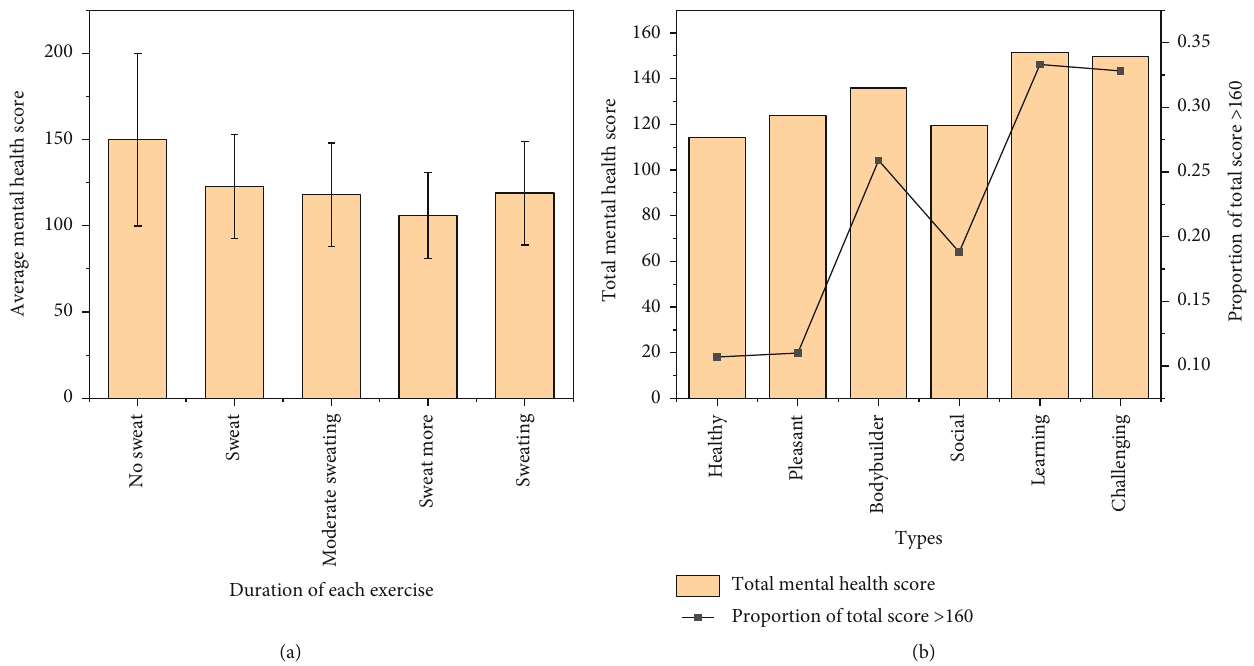
Figure 10: Results of investigation on the relevance of di ff erent exercise intensities and modes to disease belief ((a) exercise intensity; (b) exercise